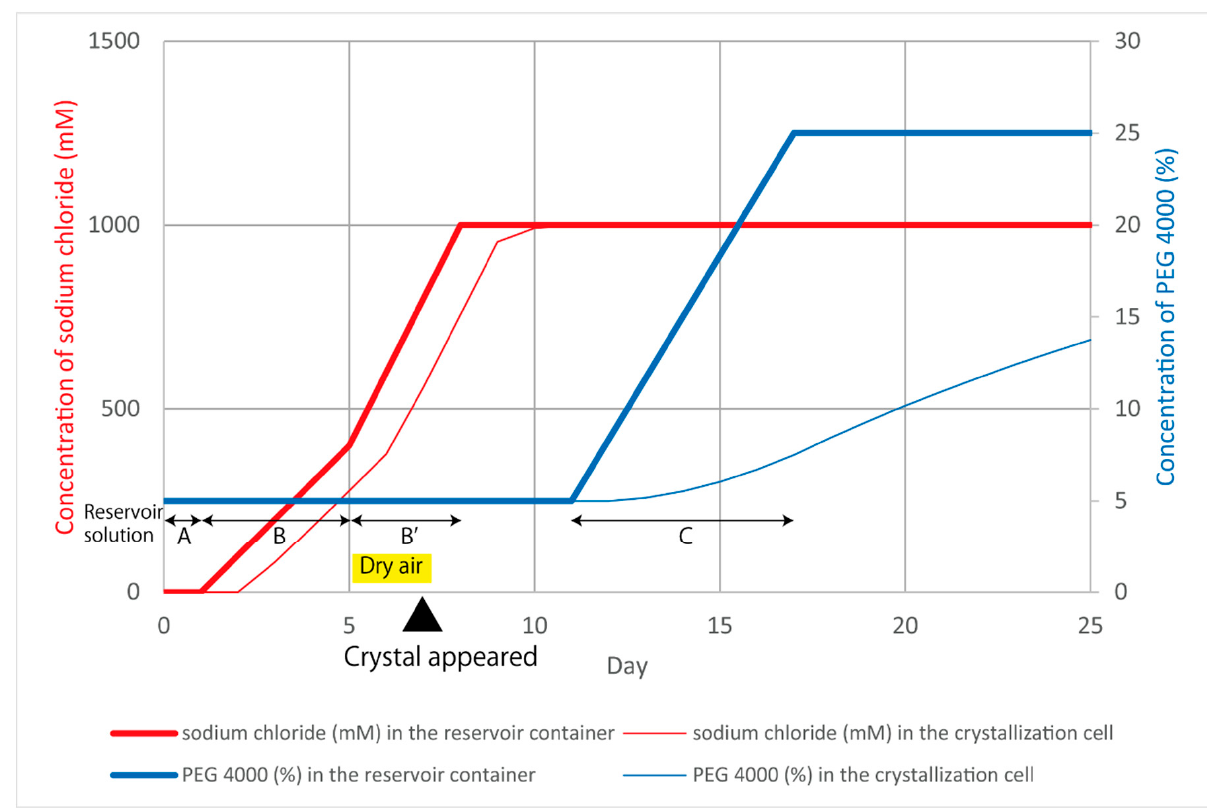
Figure 2. Controlling lysozyme crystallization conditions by changing the reservoir solution. The concentrations of sodium chloride and PEG 4000 in the reservoir container are shown as thick red and blue lines, respectively. The concentrations of those in the crystallization cell are estimated numerically and shown as thin red and blue lines, respectively. The reservoir solution flowing to the reservoir container was changed as indicated by the black double arrows: A, 5% ( w / v ) PEG 4000 at a flow rate of 100 µ L/min; B, 5% ( w / v ) PEG 4000 + 2 M sodium chloride at a flow rate of 0.2 µ L/min; B’, 5% ( w / v ) PEG 4000 + 2 M sodium chloride at a flow rate of 0.4 µ L/min; C, 50% ( w / v ) PEG 4000 + 1 M sodium chloride at a flow rate of 2 µ L/min. All solutions were dissolved in 50 mM sodium acetate buffer pH 4.5. Dry air was supplied at a flow rate of 0.5 mL/min from the beginning of B’ until the first crystal was observed.